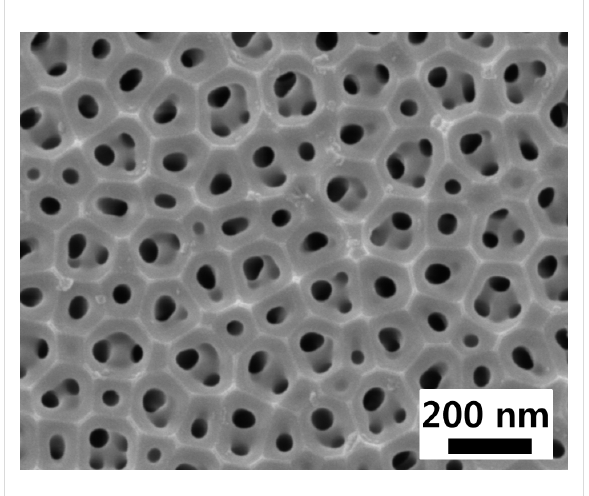
Figure 5: FE-SEM top-view image of AAO membrane with well- arrayed 80 nm-sized pores, cleaned by sonication in ethanol.